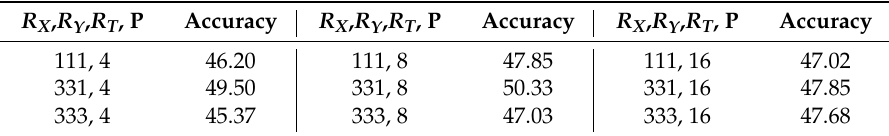
Table 3. Recognition accuracies of different parameters (%).